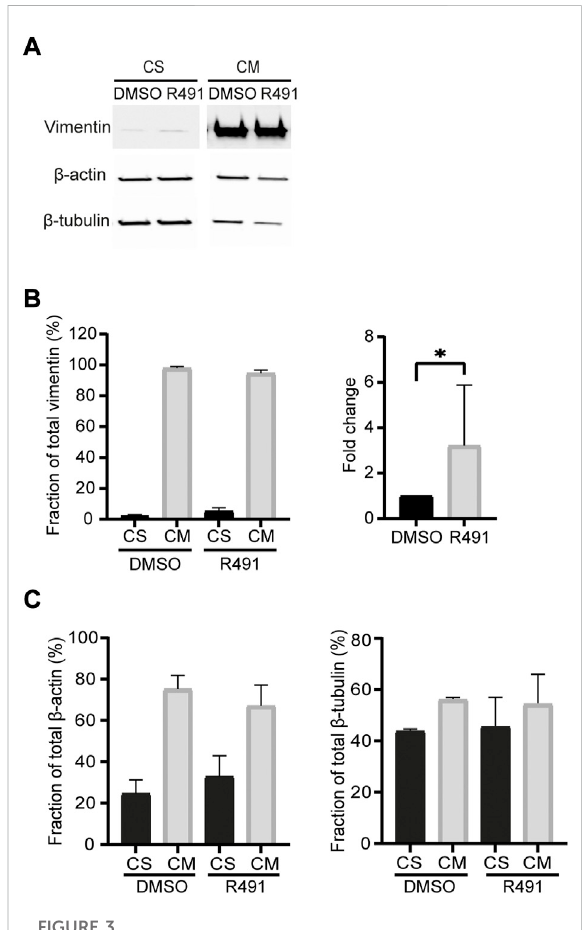
FIGURE 3 R491-treatment increases the soluble fraction of vimentin in BJ-Ras cells. (A) Representative western blot images of cells with DMSO control- or R491-treatment, analyzed for vimentin, actin and microtubules in soluble (CS) and insoluble (CM) cytoskeletal fractions, as quanti fi ed in (B , C) . The western blot images are taken from the same membrane. Graphs show means of at least 3 biological repeats. Data presented as mean ± SEM. * p <